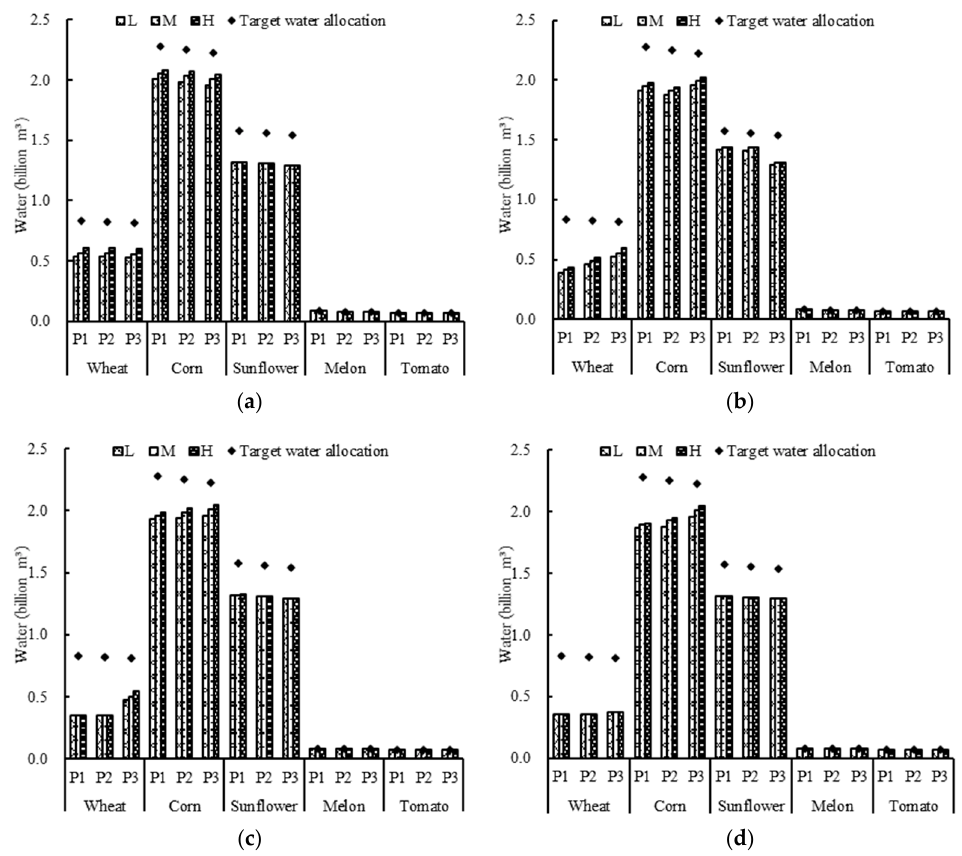
Figure 5. The agricultural water allocation in Bayan Nur City under the four scenarios of ( a ) S1, ( b ) S7, ( c ) S8 and ( d ) S9.